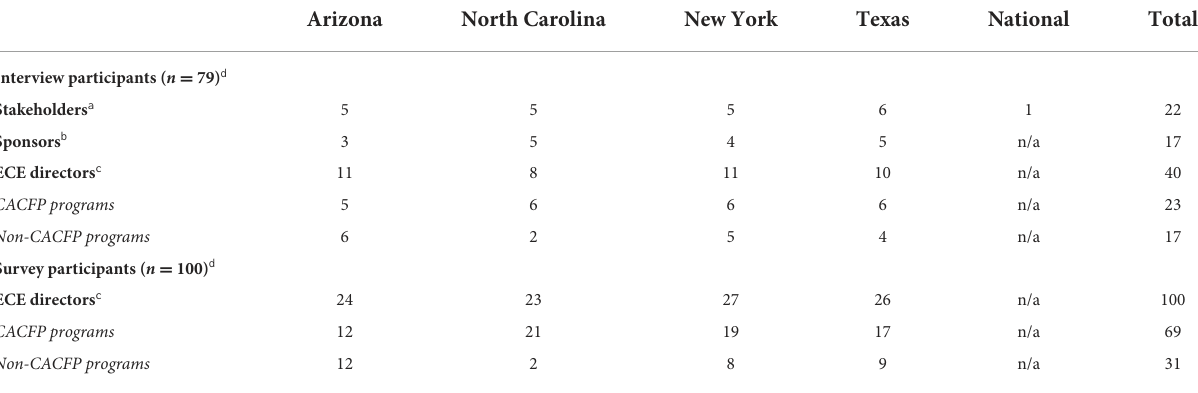
TABLE 1 Description of stakeholders, sponsors, and center-based early care and education (ECE) program directors that participated in interviews and surveys.